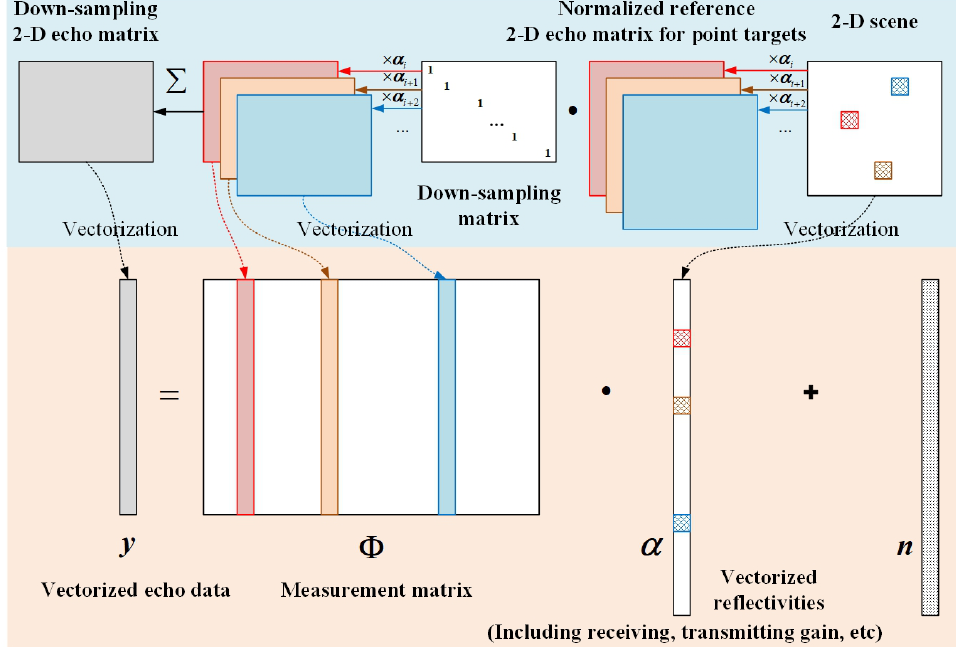
Figure 1. Schematic diagram of sparse SAR imaging